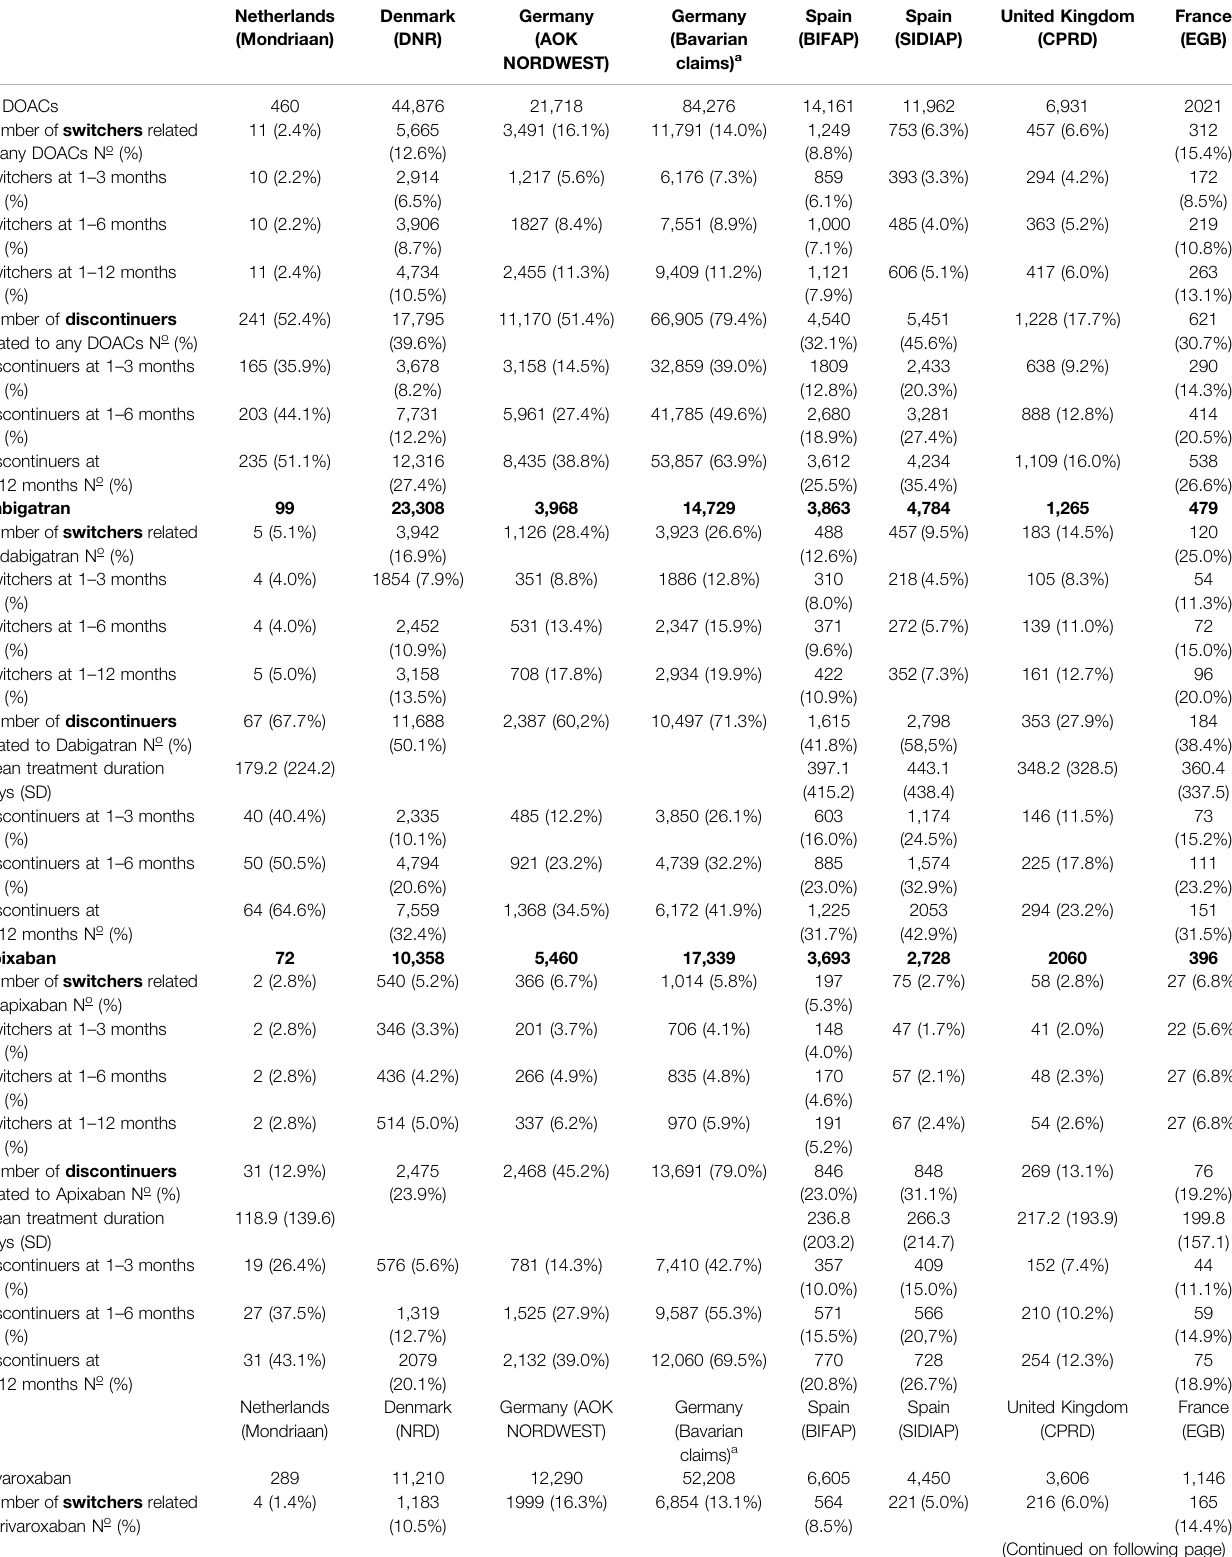
TABLE 3 | Switchers and discontinuers: all DOAC, by individual DOAC (at 3, 6, 12 months).